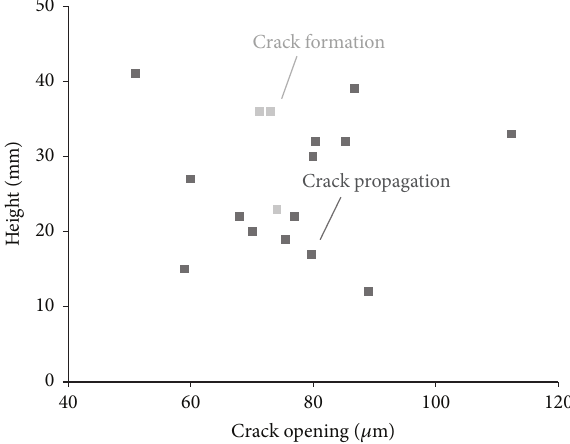
Figure 14: Local crack opening during capsules breakage.